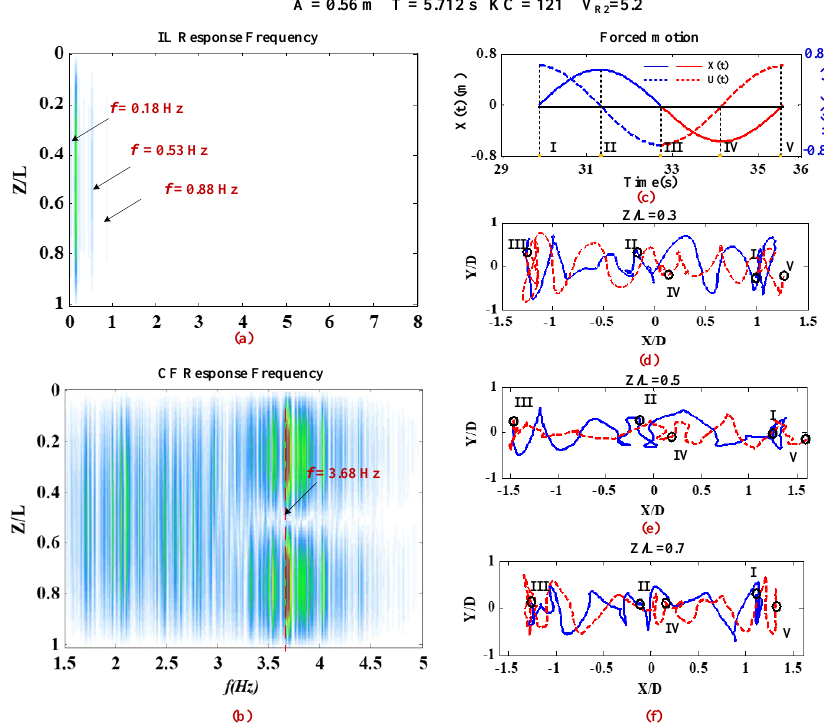
Figure 18. The spatial distribution of response frequency and displacement trajectories at different positions when KC = 121 and V R2 = 5.2.